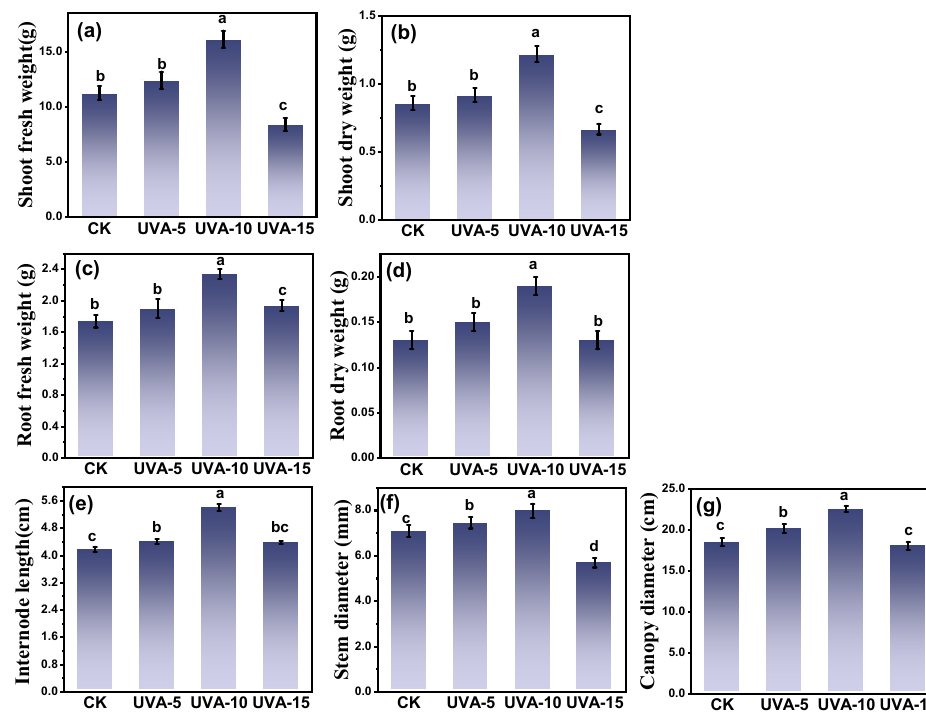
Figure 3. Agronomy traits of Chinese kale baby-leaves under different supplemental UV-A intensities. ( a ) Shoot fresh weight, ( b ) Shoot dry weight, ( c ) Root fresh weight, ( d ) Root dry weight, ( e ) Internode length, ( f ) Stem diameter, ( g ) Canopy diameter of Chinese kale baby-leaves. All data are presented as mean ± standard error ( n = 10). Different letters ( a – d ) marked upon the bar plots indicated significant differences between treatments by Duncan’s multiple ( p < 0.05).